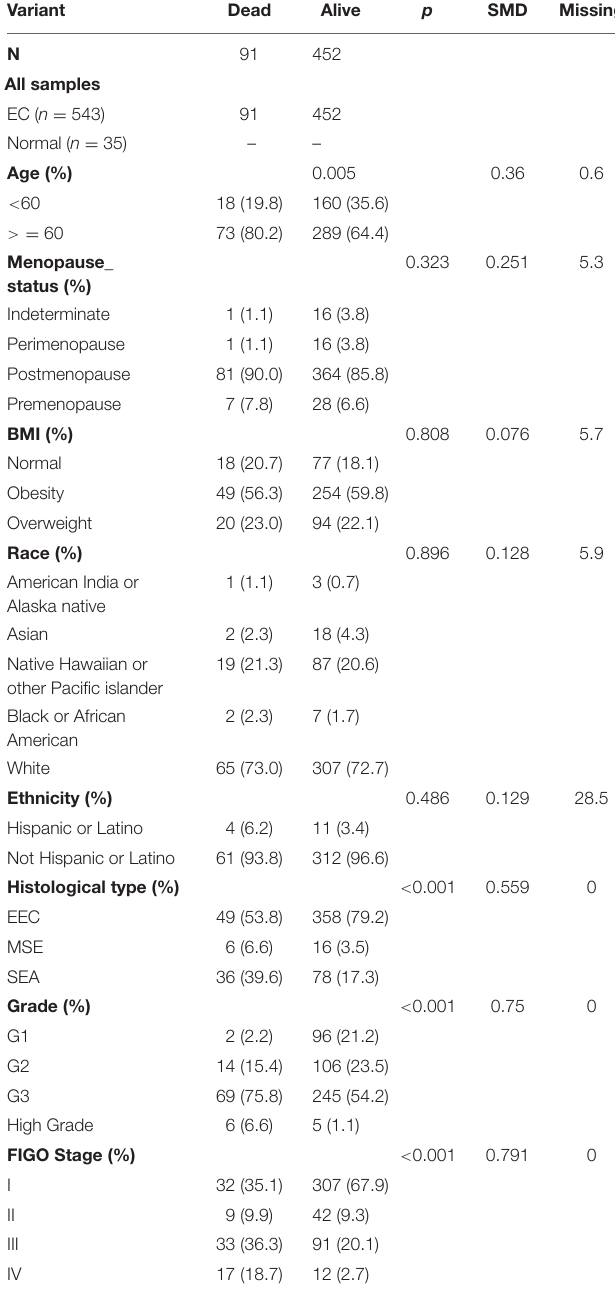
TABLE 2 | The characteristics of samples in TCGA-UCEC